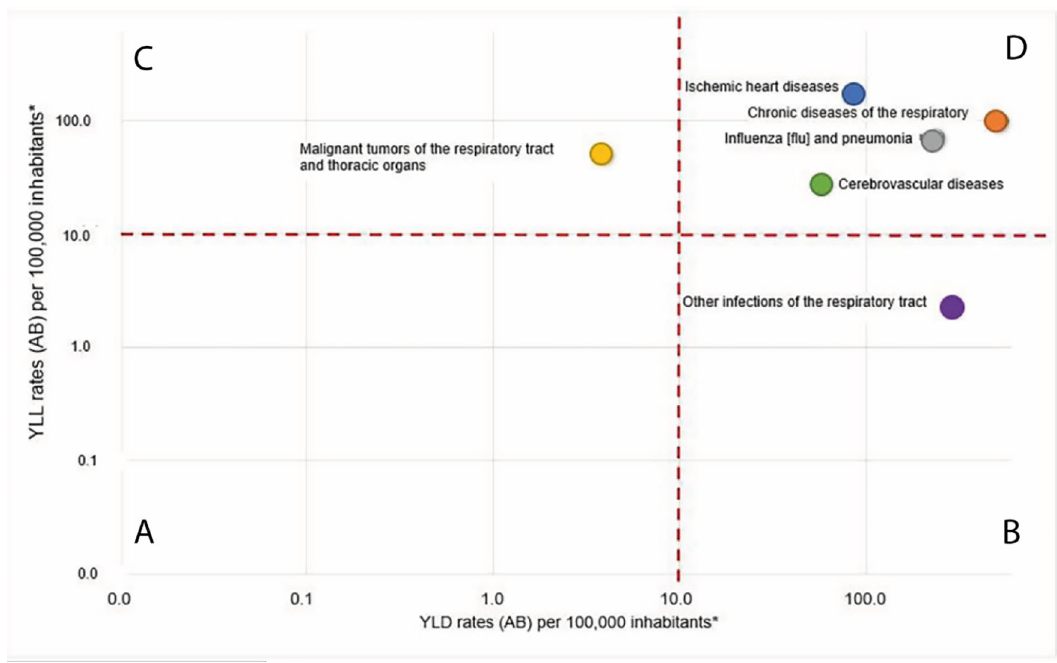
Figure 3. Relation of YLL PM2.5 and YLD PM2.5 rates per group of events, 2010 – 2016. YLLs PM2.5: Attributable years of life lost to ambient PM 2.5 pollution. YLDs PM2.5: Attributable years lived with disability to ambient PM 2.5 pollution. a Logarithmic